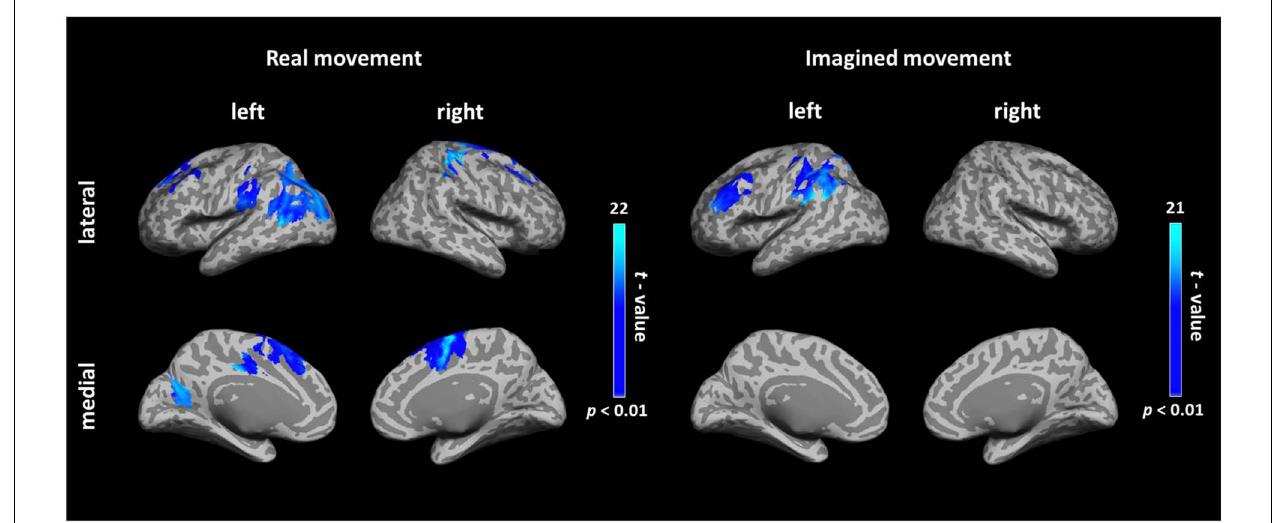
FIGURE 2 | Cortical connectivity maps during real and imagined movements. Group ( N = 10 participants) results of anatomically constrained imaginary coherence (IC) visualized on the inflated cortical